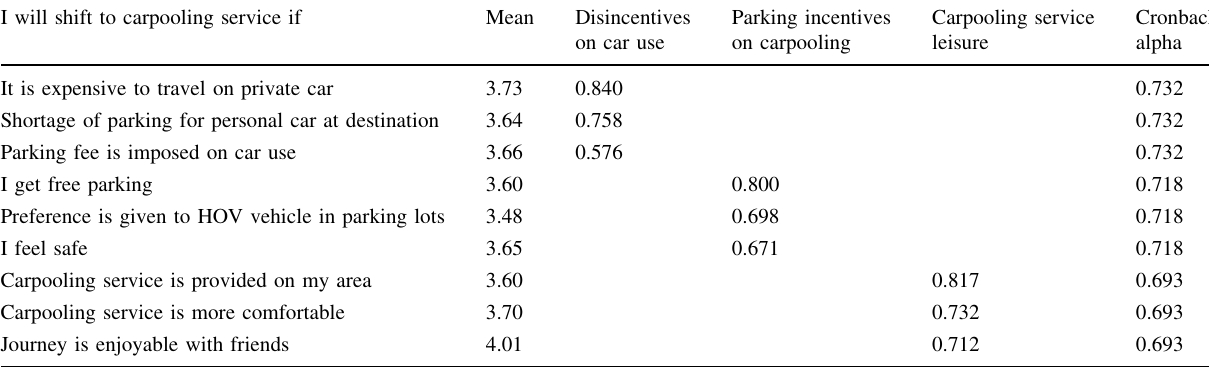
Table 3 Rotated factor loadings for propensity of shit to carpooling